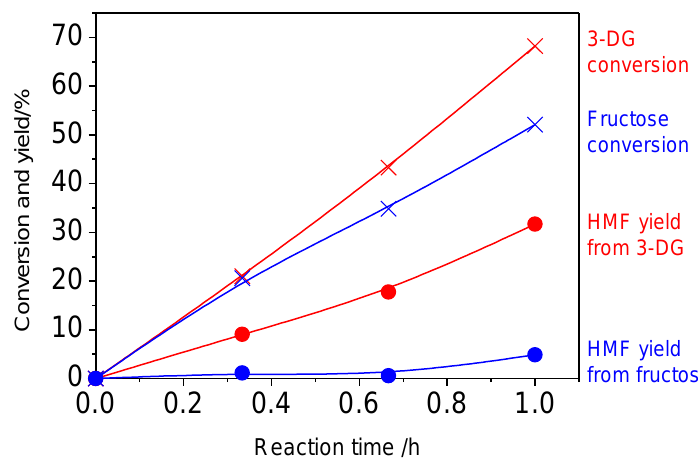
Figure 7. HMF formation from 3-deoxyglucosone (3-DG) and fructose over HNbWO 6 aggregated nanosheets. Reaction conditions : substrate (3-deoxyglucosone or fructose, 1 mg), catalyst (2 mg), water (1 mL), 413 K.